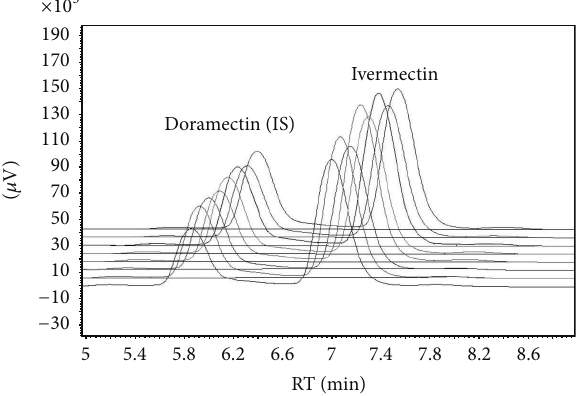
Figure 2: Chromatograms of animal feed samples analysed in homogeneity studies. Mean concentration: 3.87 mgkg −1 , standard deviation: 0.19mgkg −1 , and CV: